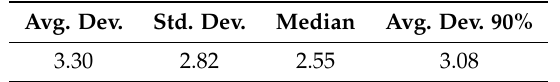
Table 3. Average deviation (as %) of the prediction of the ultimate tensile strength Avg. Dev.